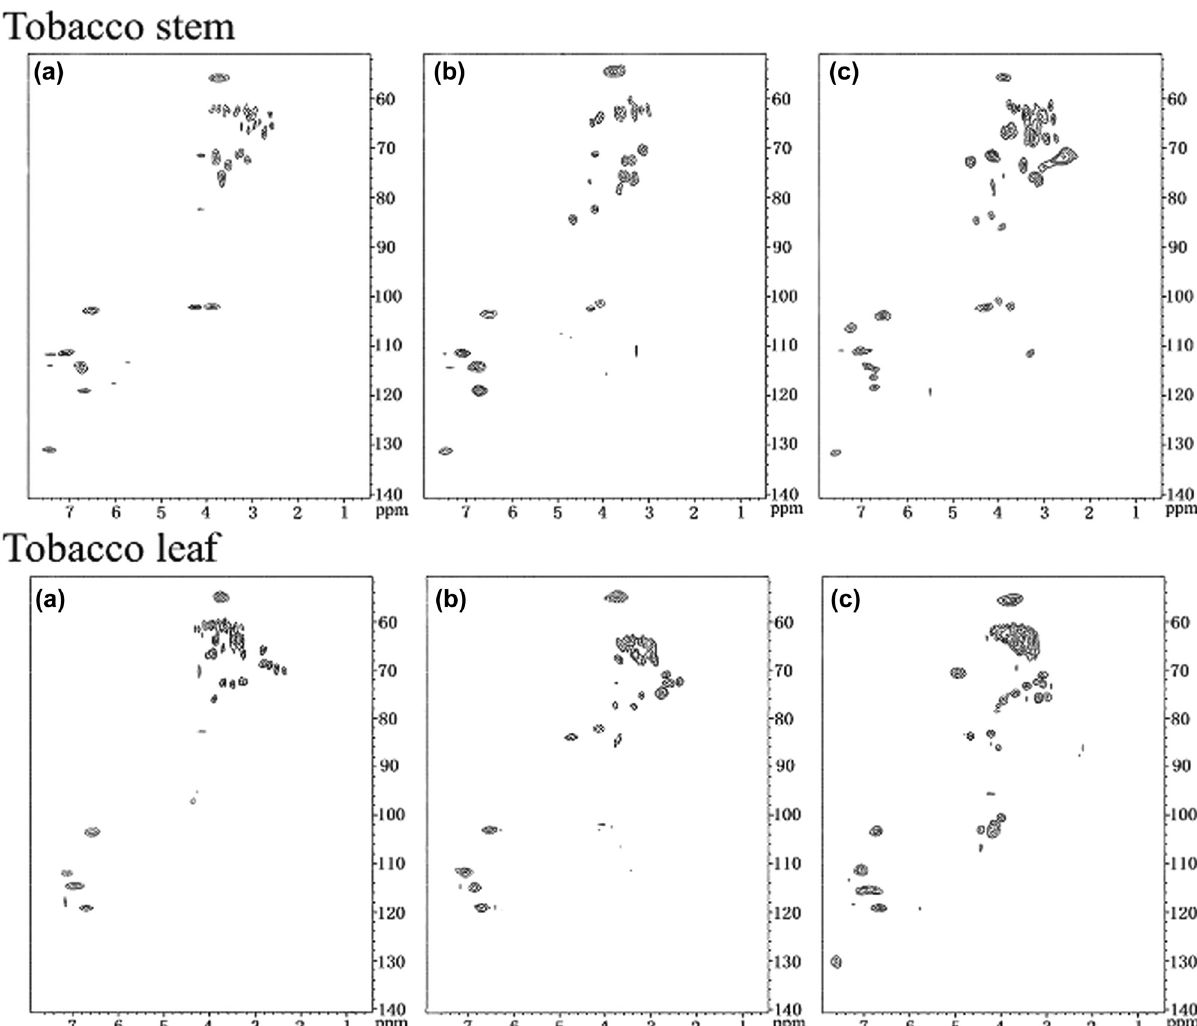
Figure 2: 2D HSQC NMR spectra of plant cell walls in di ff erent solvents: ( a ) DMSO - d 6 , ( b ) DMSO - d 6 /pyridine - d 5 , ( c ) DMSO - d 6 /HMPA - d 18